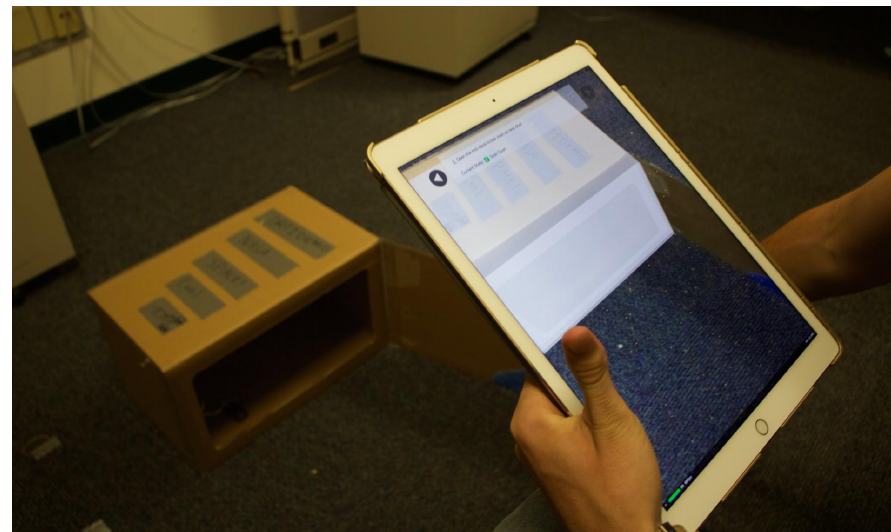
Figure 3. User interface demonstrating detected volume and providing a procedure execution